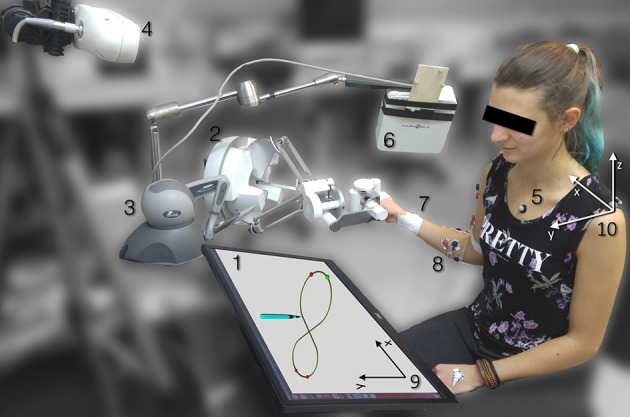
Experimental setup: the user performs the task looking at a monitor laid flat on a table (1) while teleoperating using either a parallel link haptic device PL (2) or a serial link haptic device SL (3) while the thorax and arm kinematic are acquired with an optical camera (4) and reflective markers (5) and with electromagnetic tracker (6) and markers (7). The EMG activation is also acquired with bipolar electrodes (8).The virtual reference frame (9) and the shoulder reference frame (10) are grossly aligned in the setup phase.